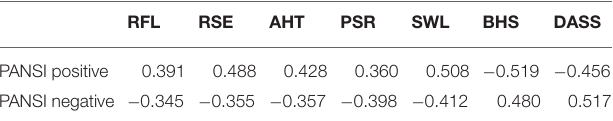
TABLE 1 | Correlations of PANSI with other